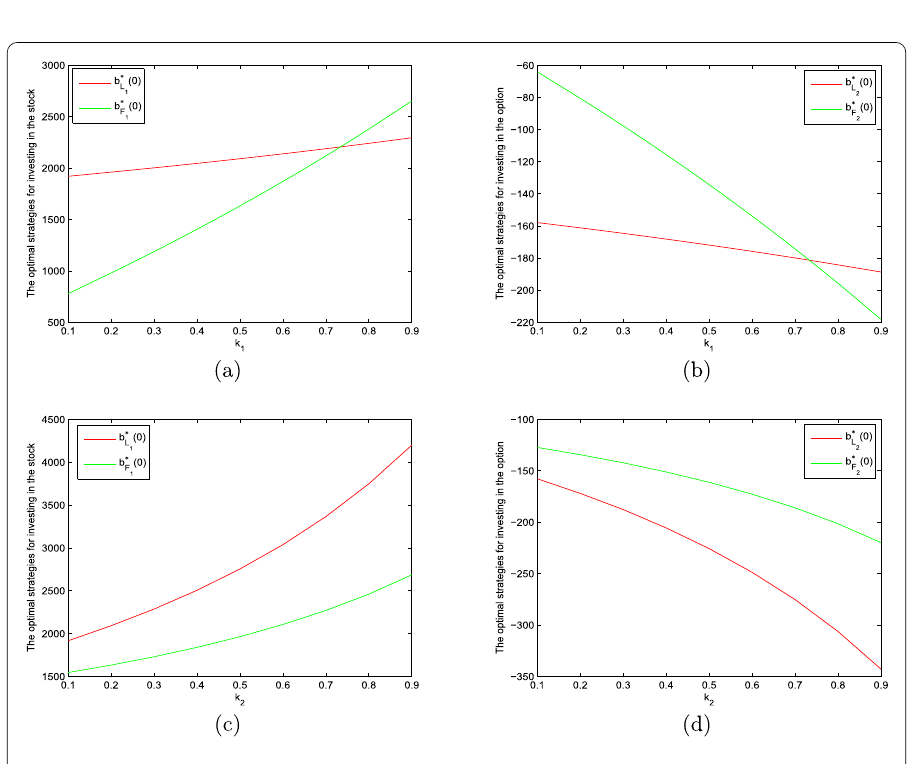
Figure 2 Sensitivities of optimal investment strategies to parameters k 1 and k